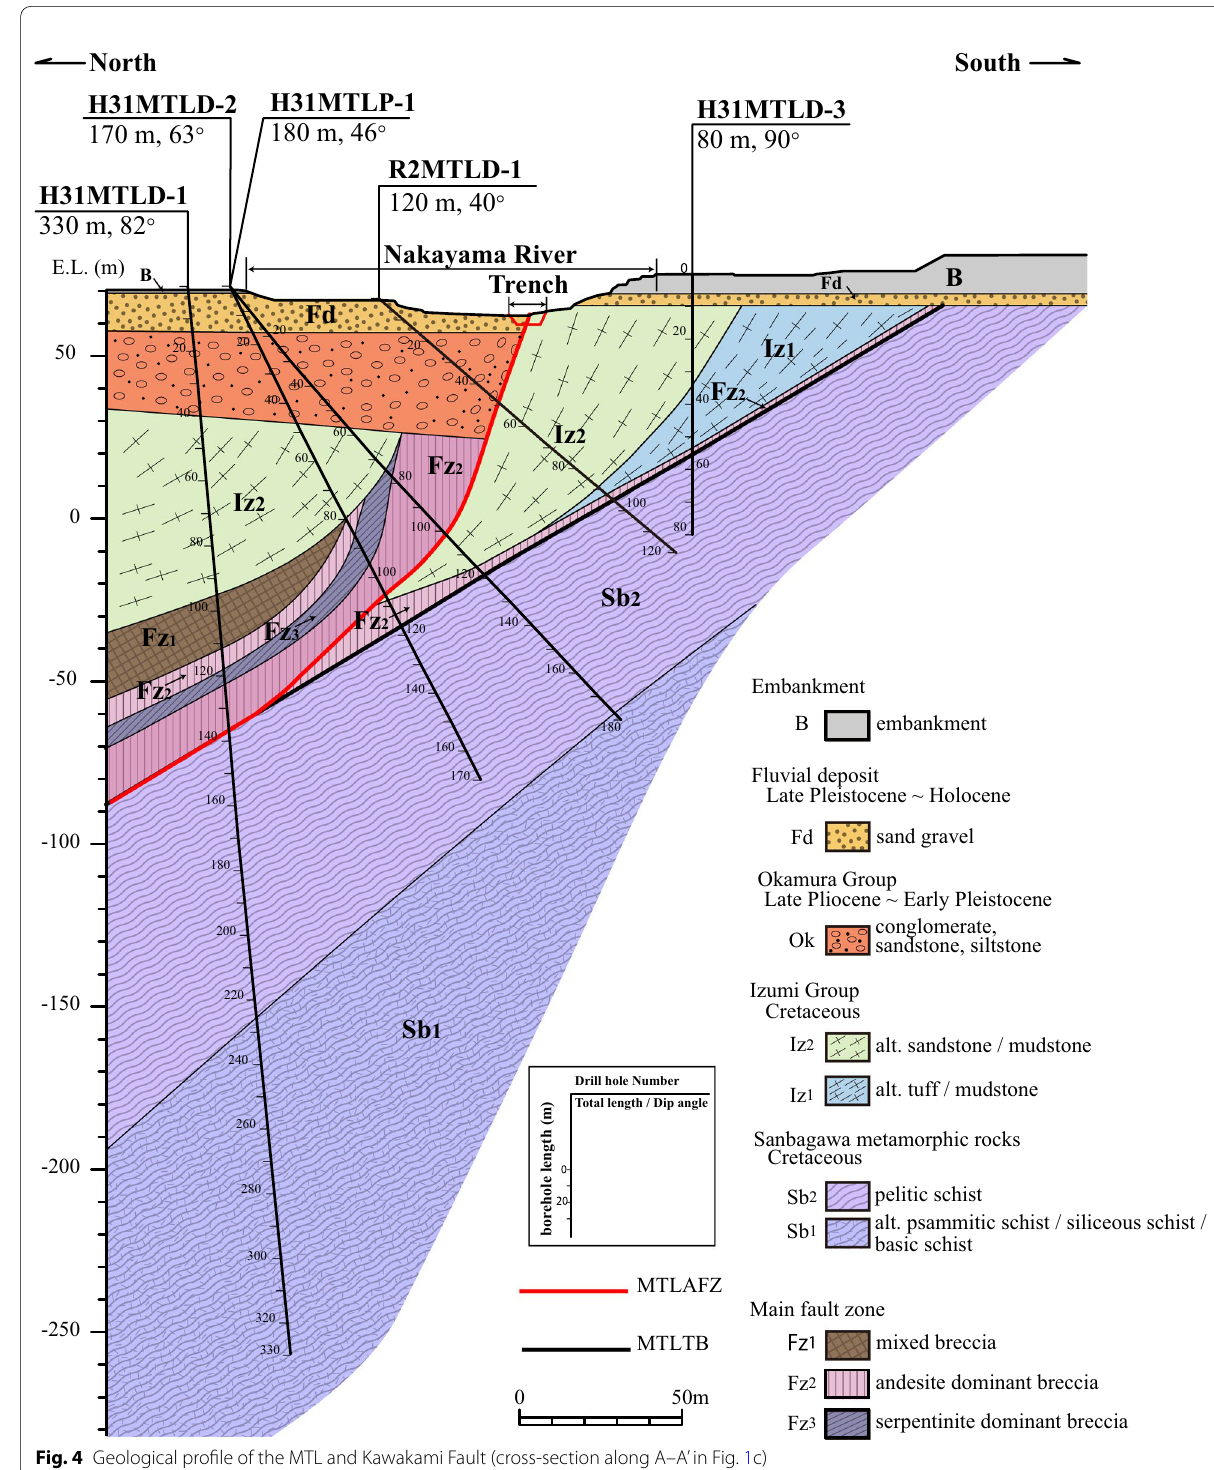
Fig. 4 Geological profile of the MTL and Kawakami Fault (cross-section along A–A’ in Fig.